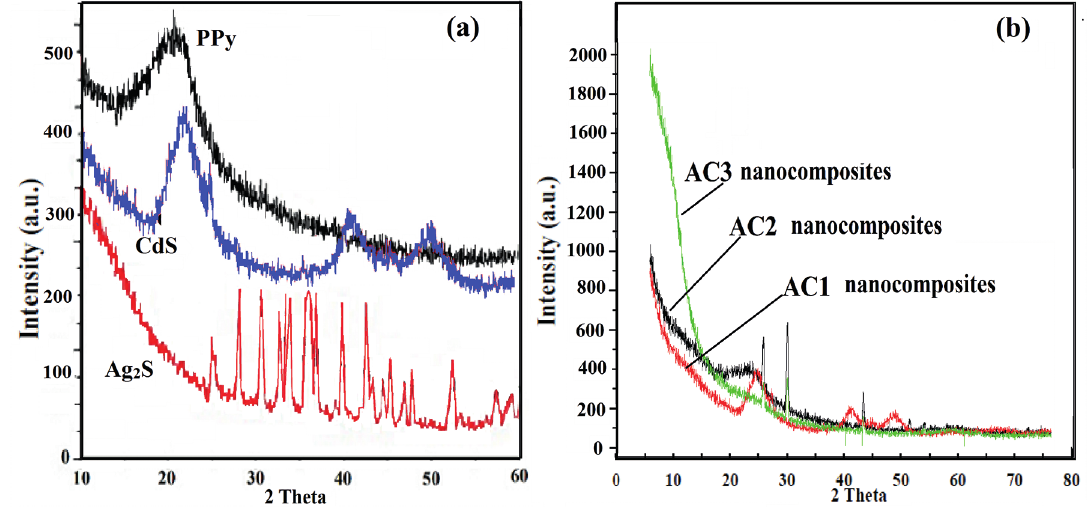
S and CdS nanoparticles and (b) PPy/(Ag2S:CdS) hybrid nanocomposites. 2